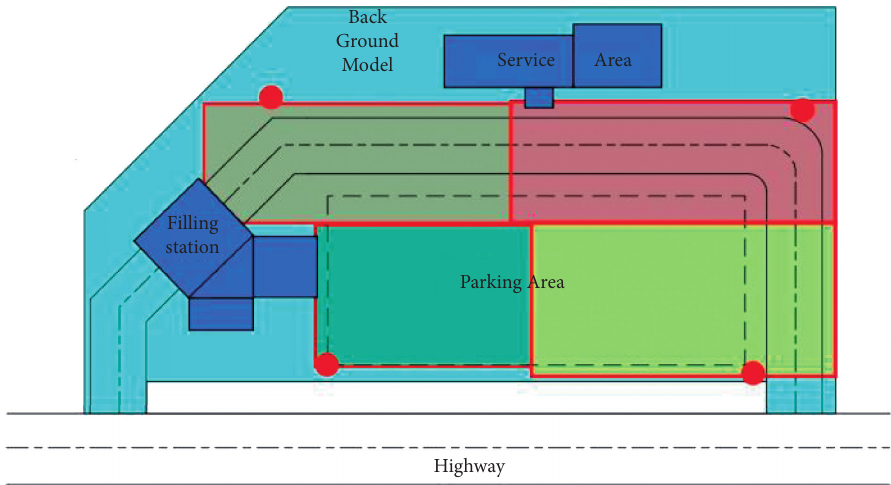
Figure 5: Stitched aerial view image of the service station.